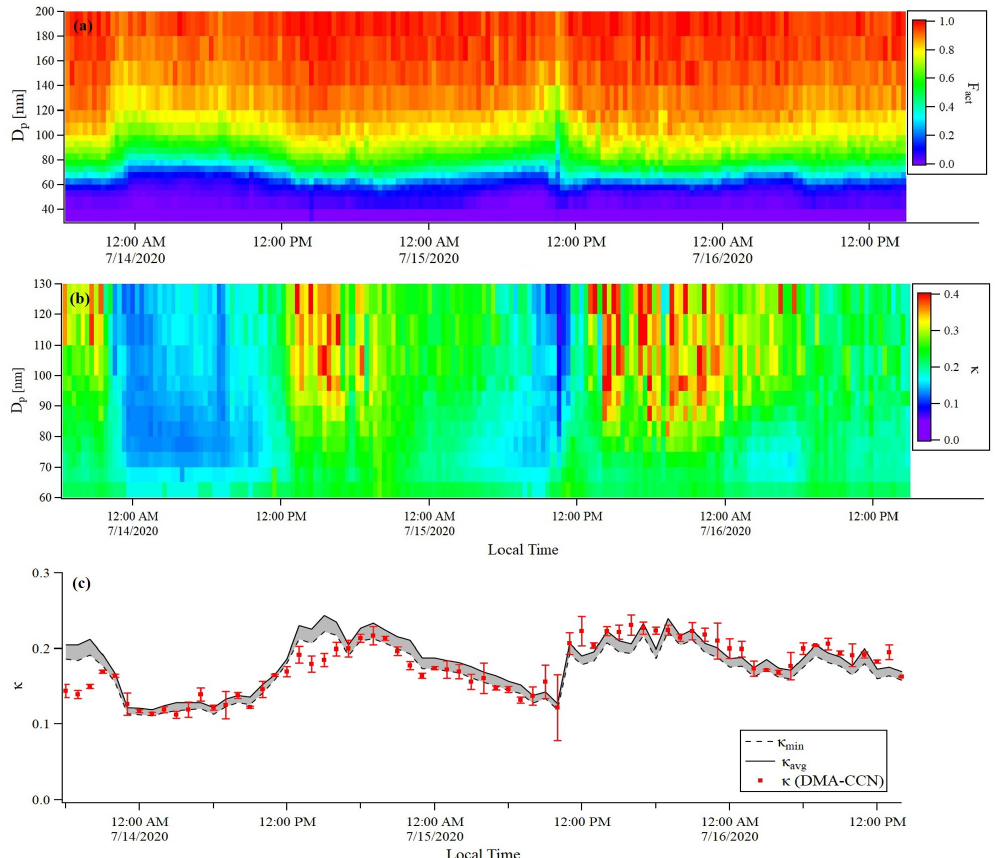
Figure 9. Time series of (a) F act , (b) κ distribution of BS2-CCN measurement for the 0.63% S (d T = 8K) condition, and (c) hourly averaged κ values for DMA-CCN (red dots, bar indicates the standard deviation of κ ) and BS2-CCN (grey shaded area for the range between κ avg , indicated by the black solid line, and κ low , indicated by the black dashed line) measurements. The κ high is excluded in this figure. Measurement period was 13 July–16 July 2020.